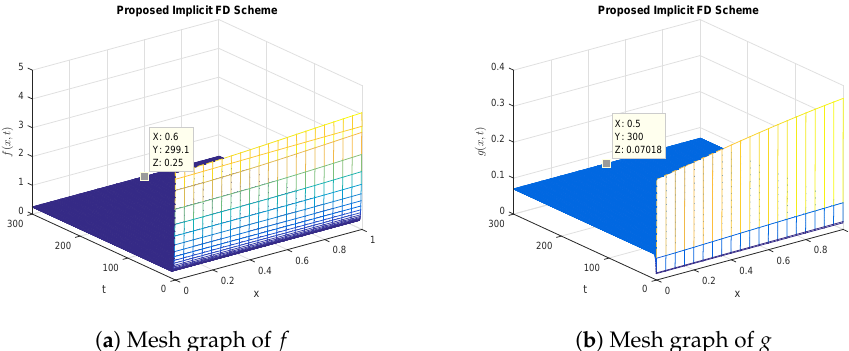
Figure 6. Graphical solution of f , g (concentration of substances) using NSFD implicit method at a = 3.5, b = 0.25, χ 1 = 6, χ 2 = χ ∗